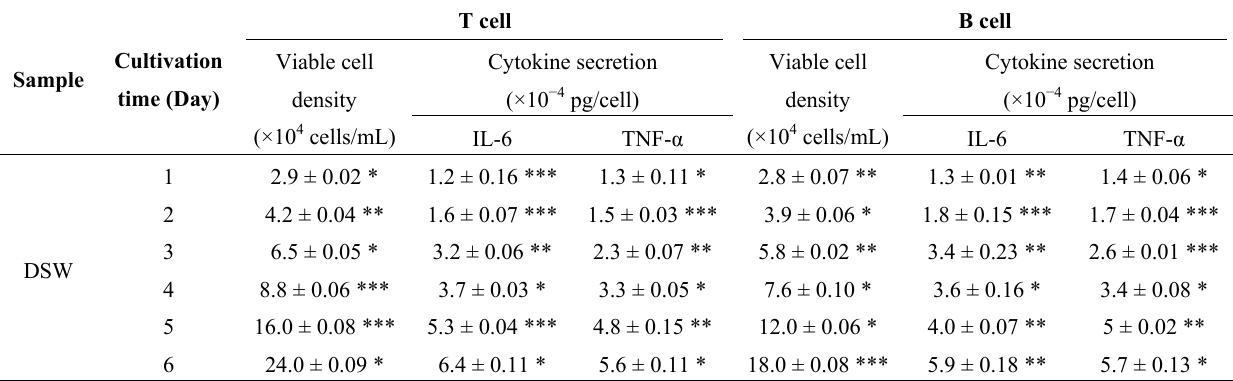
Table 2. Cell growth and IL-6 and Tumor Nucreosis Factor- α (TNF- α ) secretion from human immune T cells after adding 1.0 mg/mL of S. maxima extracted under various cultivation